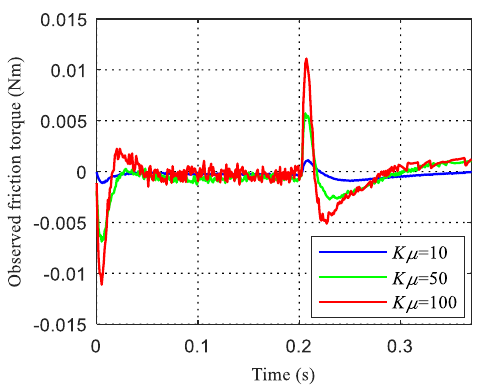
Figure 8. Observed total friction torque mapped to the motor side at low velocities. Table 4. Motor velocity step response time .